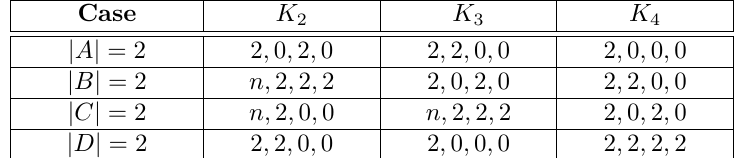
Table 3: Number of active bytes in every column of K 2 , K 3 , K 4 when we have two active bytes in A or B or C or D , where n is either 3 or 4.